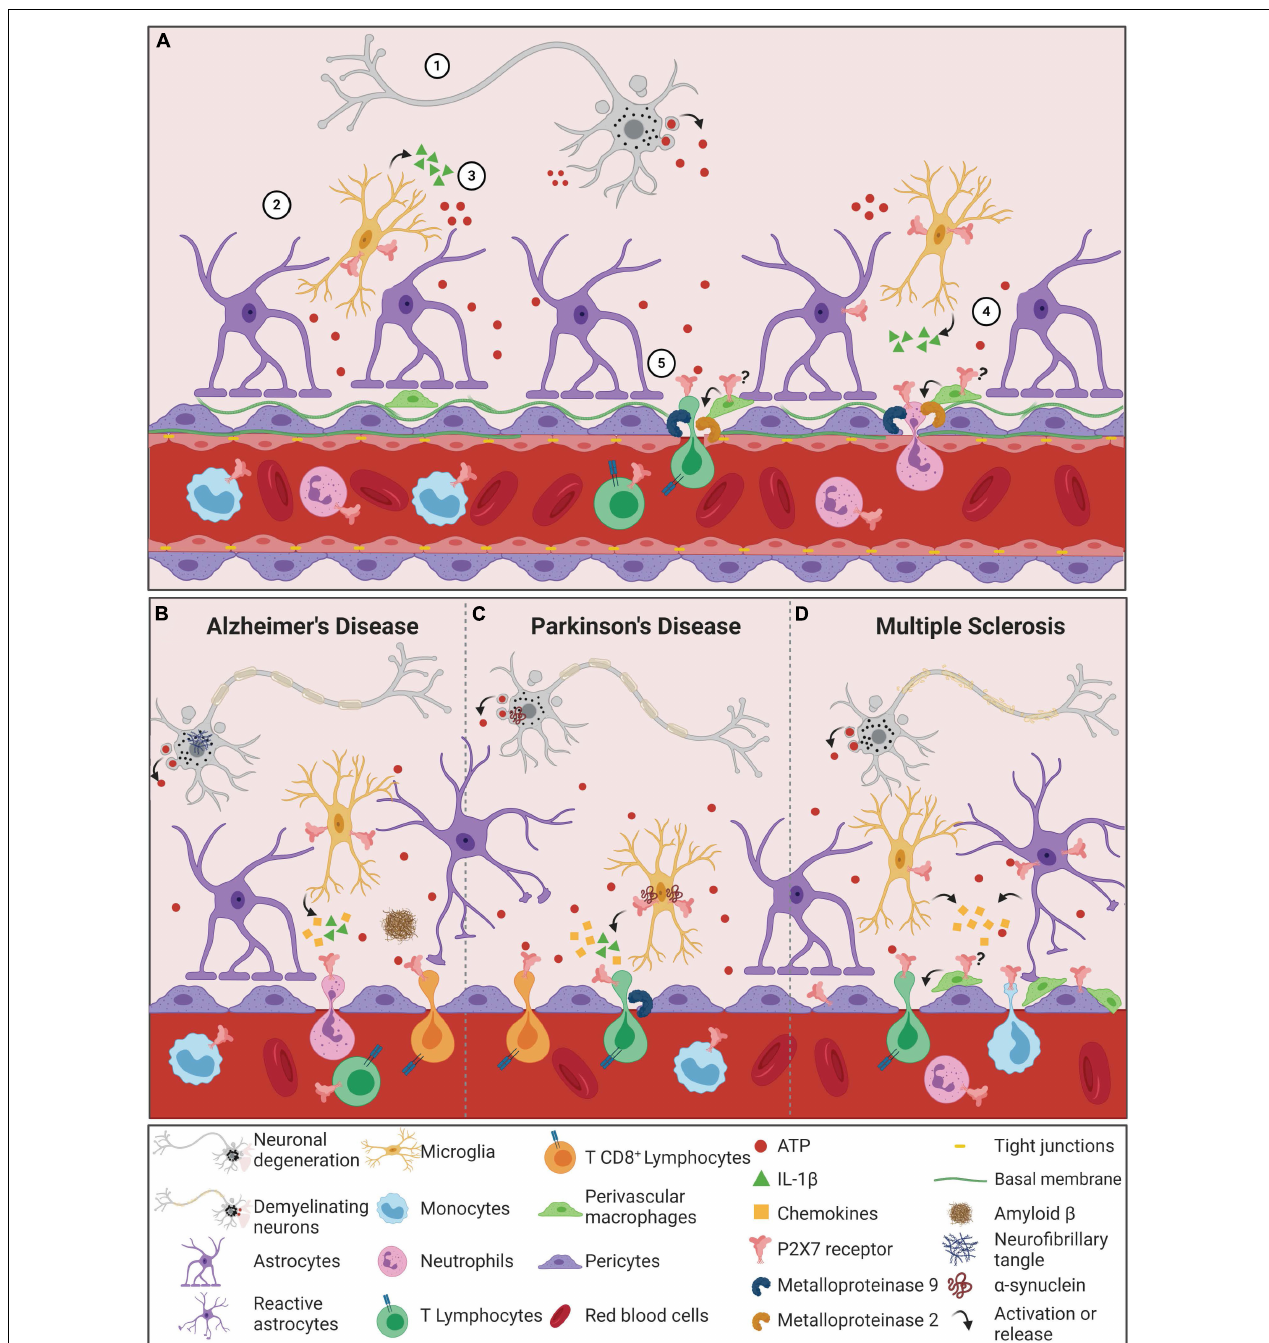
FIGURE 2 | The P2X7 receptor in the process of Blood-Brain Barrier permeabilization during neurodegenerative diseases. (A) Blood-Brain Barrier permeabilization through P2X7 receptor signaling begins with cellular damage, which triggers cell death and consequently ATP release into the CNS microenvironment (1) . ATP content above physiologic ranges activates P2X7 receptors in microglial cells (2) , which in turn leads to the production and release of IL-1 β and other cytokines and chemokines (3) . Moreover, the active ATP/P2X7 receptor pathway augments metalloproteinase (MMP) activities, causing TJ and BM protein degradation and consequently BBB destabilization (4) . The outcome of these combined events is the peripheral immune cell invasion of the CNS. Since T cells and neutrophils express P2X7 receptors, the amount of ATP released by the damaged cells can also activate this receptor in these cells. The result is the shedding activation of adhesion proteins and the production and release of cytokines and MMPs, promoting an inflammatory and invasive feedback mechanism (5) . In neurodegenerative diseases, the neuronal death process induces the release of high concentrations of ATP into the extracellular milieu. (B) In AD pathogenesis, ATP binds to P2X7 receptors that are overexpressed in microglial cells. The microglial activation depends on P2X7 receptor expression/activity to react against A β peptides. P2X7